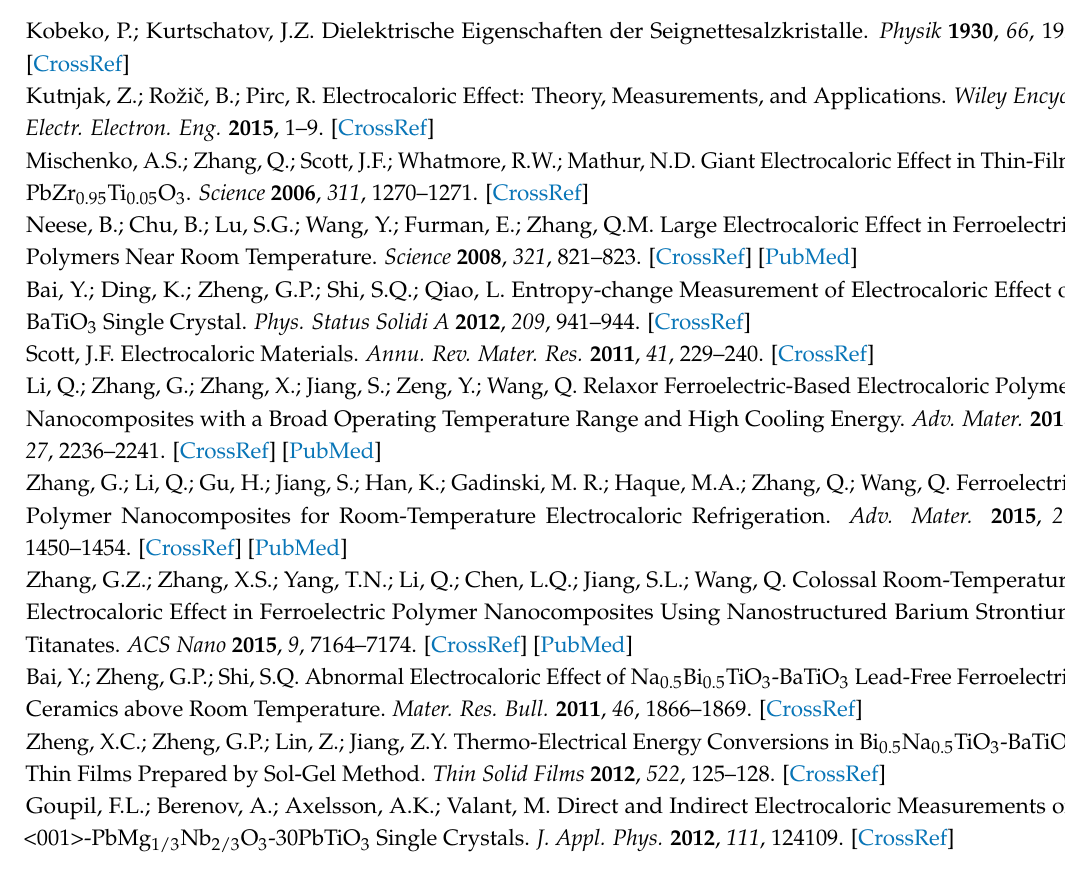
Figure S1: XRD results, Figure S2: FT-IR spectra, Figure S3: DMA